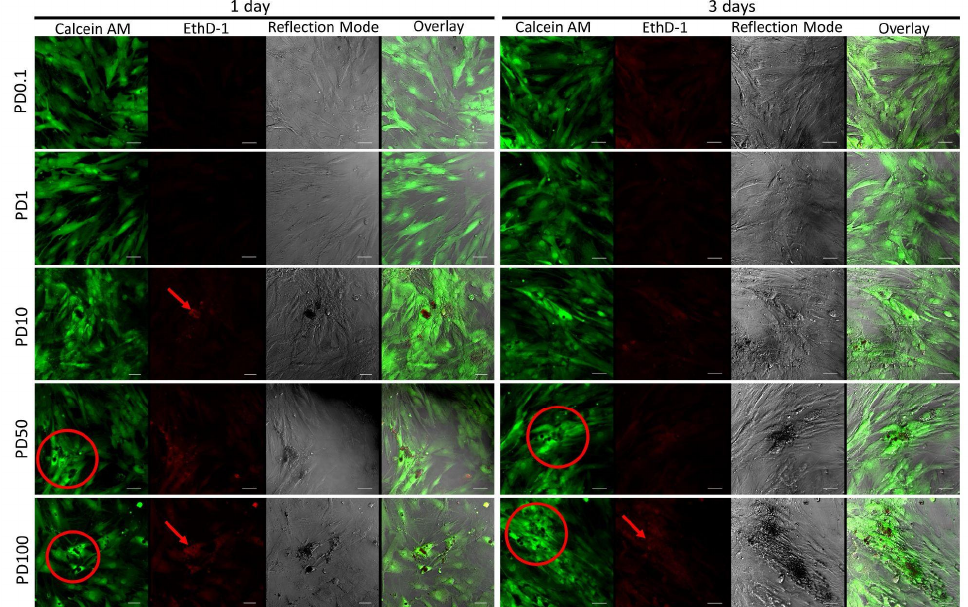
Figure 10. Confocal microscopy images of hMSCs cultured for 1 and 3 days in PLGA containing DOX at concentrations of 0.1, 1, 10, 50, and 100 µ g/mL identified as PD0.1, PD1, PD10, PD50, and PD100, respectively; the observation depicts live/dead cells (green and red, respectively) and small and large microsphere aggregates (arrows and asterisks, respectively); bars 50 µ